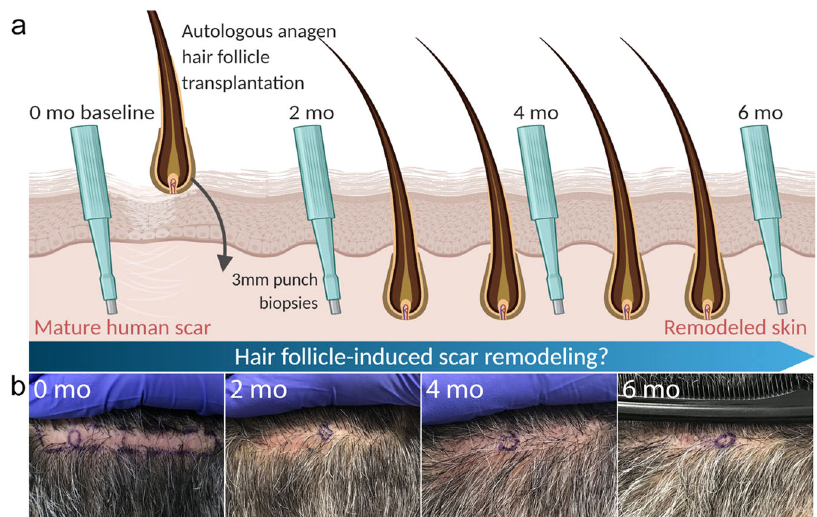
Fig. 1 Schematic of the experimental outline and hypothesis. a We established a pilot clinical study whereby autologous anagen hair follicles were transplanted into mature scalp scars. We collected full-thickness skin biopsies of scars before (baseline at 0 months (mo)) and at 2, 4, and 6 months after hair follicle transplantation (2, 4, 6 mo). We compared the morphology and transcriptional signature of fi brotic tissue to test our hypothesis that anagen hair follicles can remodel mature scar tissue towards a healthy phenotype. Schematic created with BioRender.com. b We recruited three individuals with mature (at least 4 years old) normotrophic scars formed post-surgically on occipital scalps. Circles indicate areas where the full-thickness biopsies were can remodel mature scars in human skin, similar to how they remodel healthy tissue in murine skin. We therefore took advantage of the routine procedure performed in hair transplan- tation clinics whereby anagen hair follicles are transplanted into scalp scars to camou fl age the hairless fi brotic area formed as a result of previous hair transplantation surgeries, and designed a pilot clinical study to test this hypothesis in human skin (Fig. 1). To test if tissue remodelling is induced by anagen hair follicles transplanted into scars, we compared mature fi brotic tissue before (0 months) and after (2, 4, 6 months) hair follicle transplantation and found a shift towards the morphology and genetic pro fi le of healthy skin. The results of this study lay the foundation for designing therapeutic strategies that dynamically remodel mature